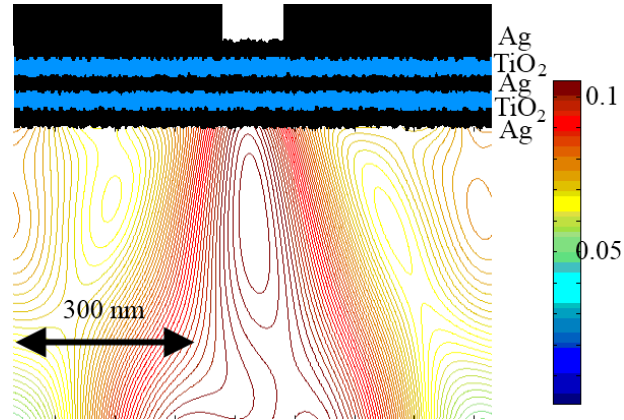
Figure 3: Distribution of module of electric field after passing through hyperbolic metamaterial with rough surface.